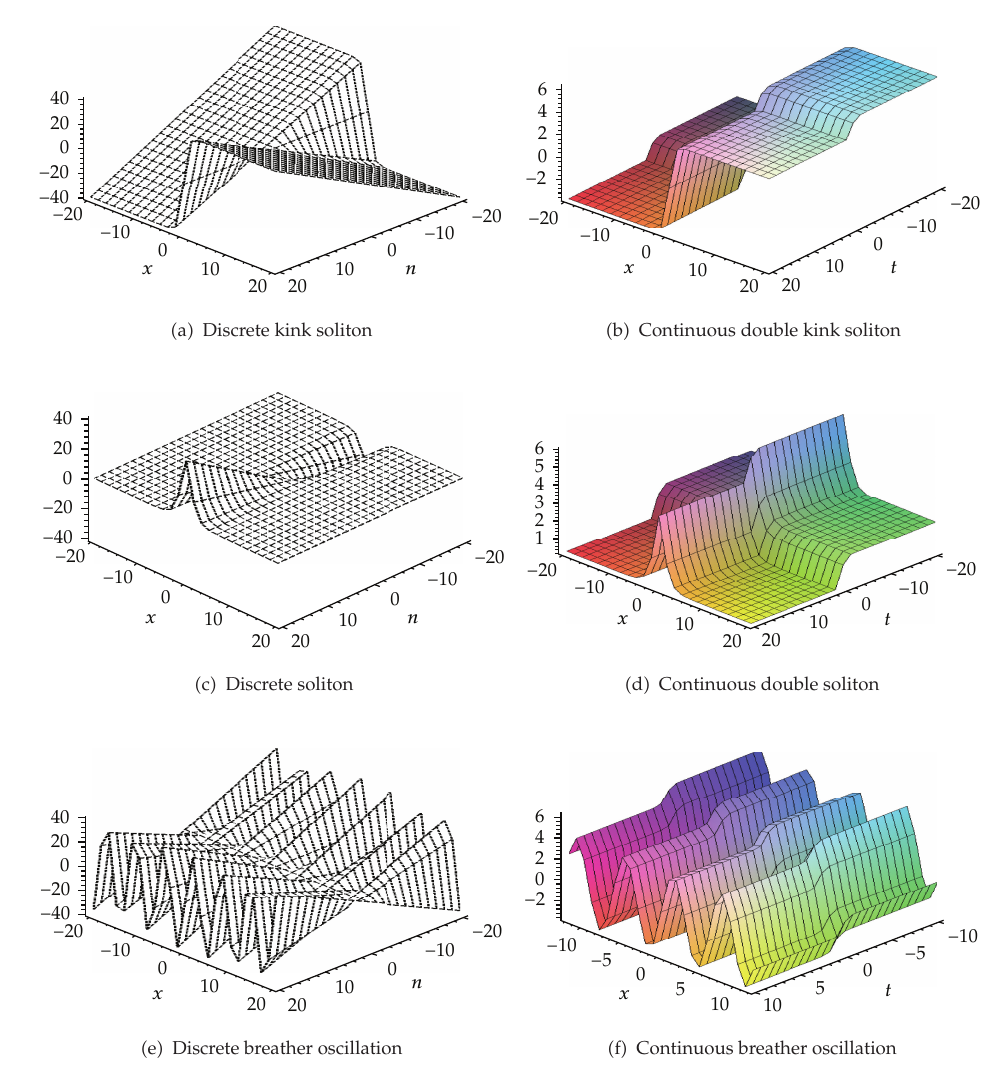
Figure 5: The solutions u n in (cid:2) 3.46 (cid:4) , (cid:2) 3.47 (cid:4) and (cid:2) 3.48 (cid:4) show six shapes of discrete and continuous solitons, and discrete and continuous breather